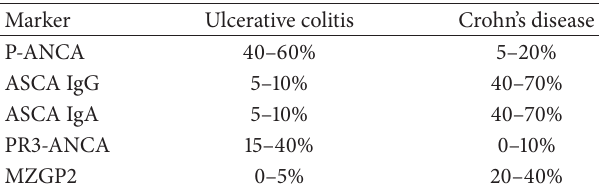
Table 2: Prevalence of autoantibodies in ulcerative colitis